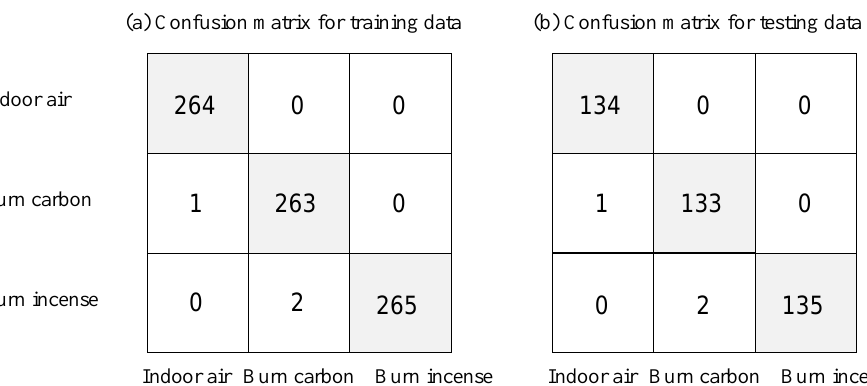
Figure 5. ( a ) Confusion matrix for training data; ( b ) confusion matrix for testing data.